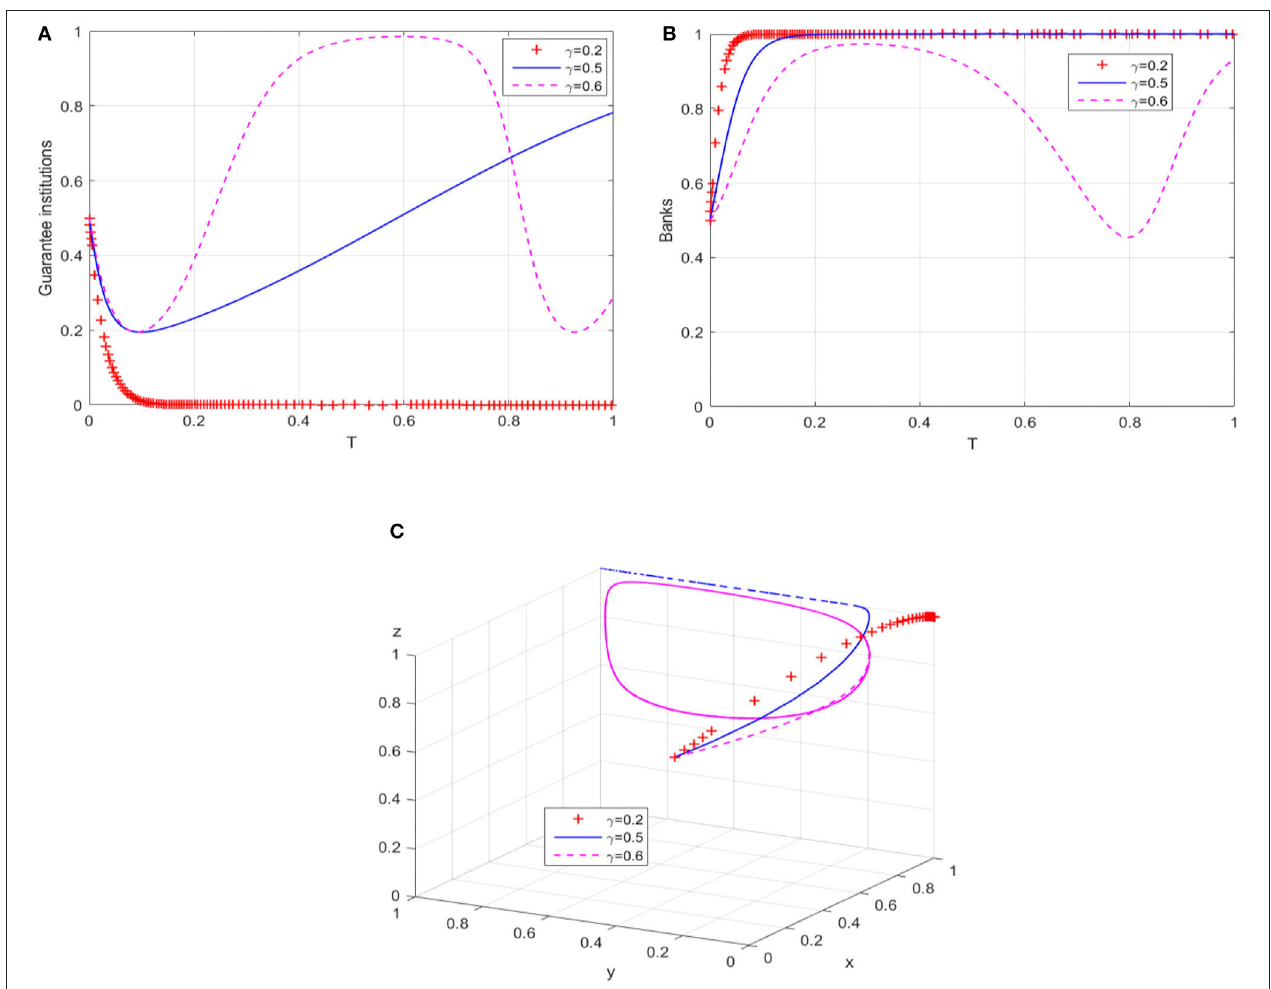
FIGURE 4 | The breakthrough effect of path 3 on low-level equilibrium. (A) Guarantee institutions (B) Banks. (C) Game system of financing guarantee